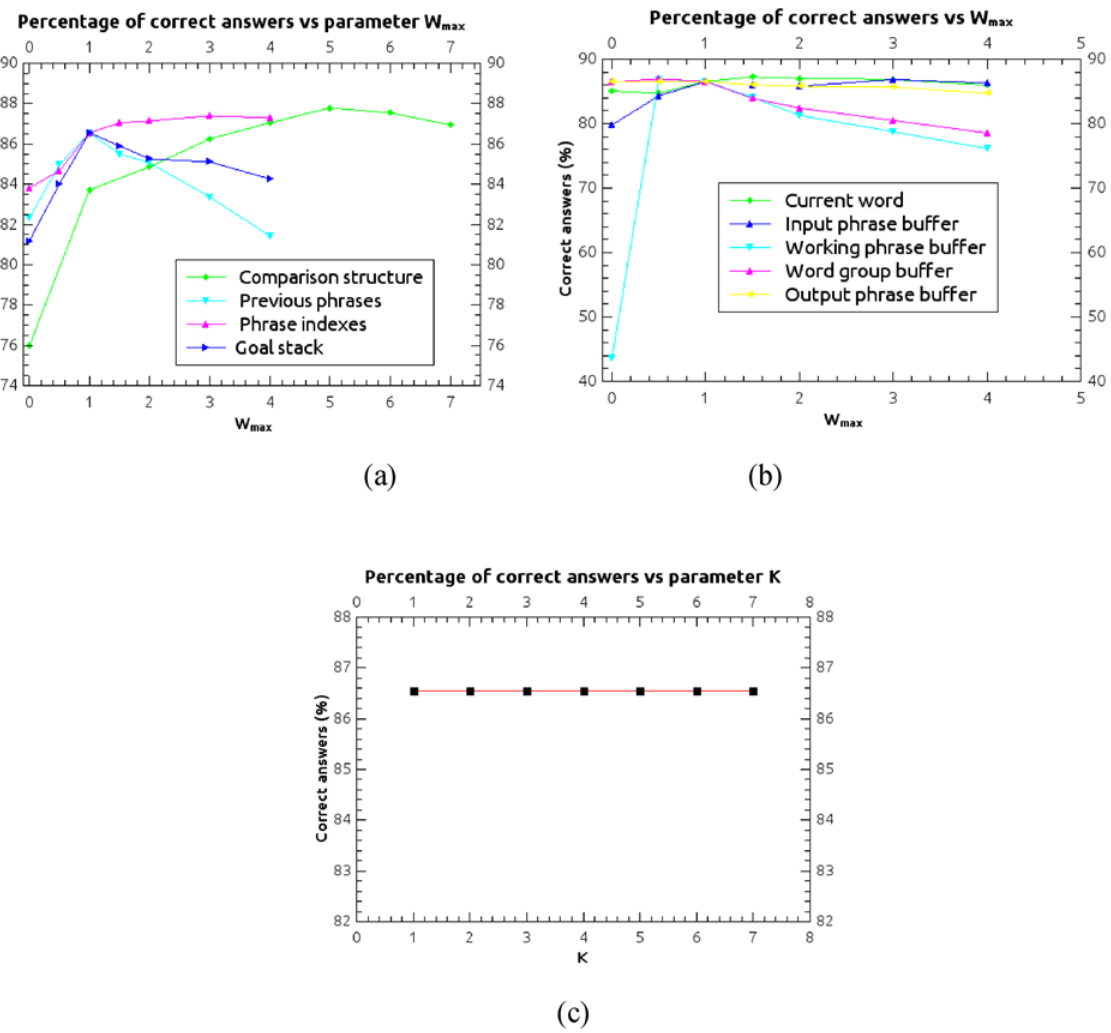
Fig 12. Percentage of correct answers over the total number of expected answers, evaluated on the first three learning sessions: [(a) and (b)] as functions of the weight-saturation value W max for the main components of the system; (c) as a function of the parameter k used for the k -winner- take-all algorithm in the state-action-association